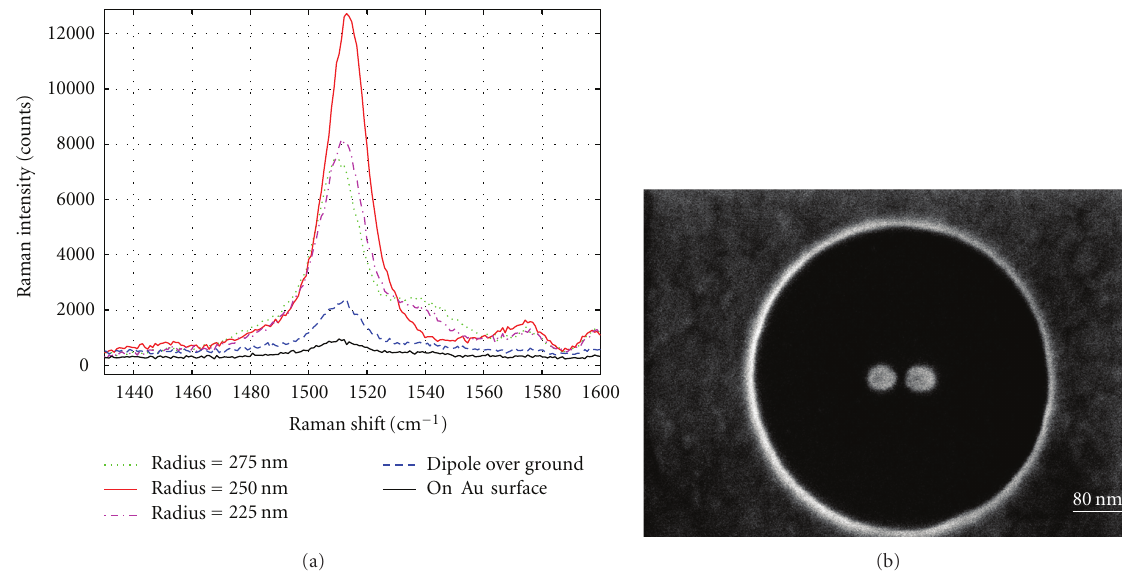
Figure 7: (a) Raman spectra from the nanoantenna structure for various radii of circular reflector, dipole over a ground plane, and the top unmilled Au surface. (b) Scanning electron microscopy image of the fabricated circular waveguide nanoantenna.